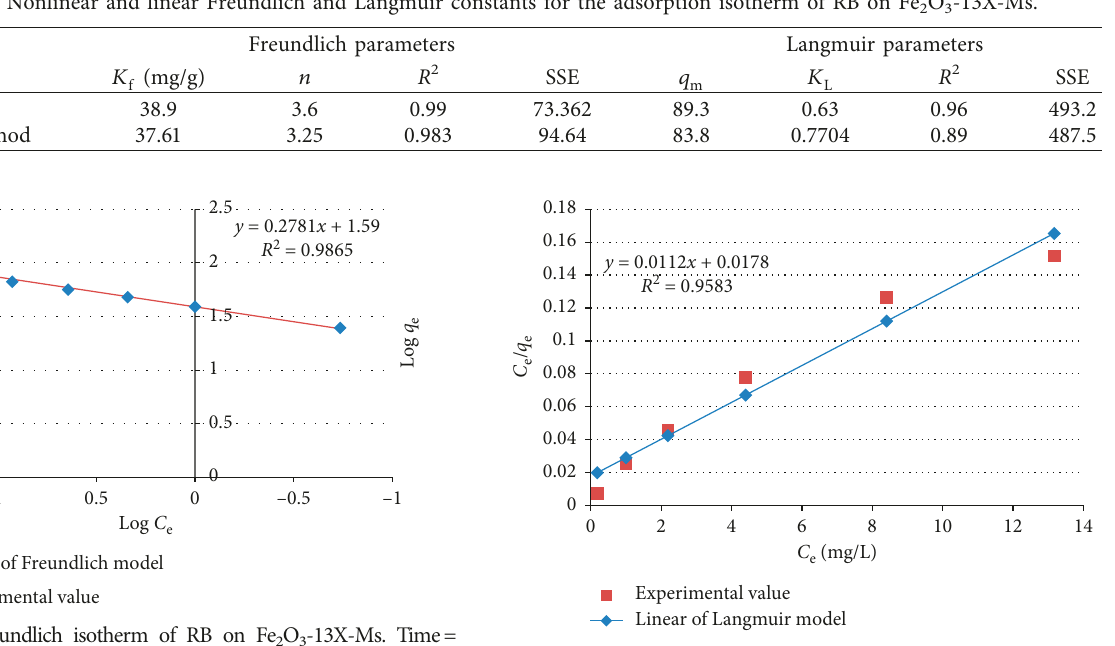
3, and surfactant amount (cid:30)